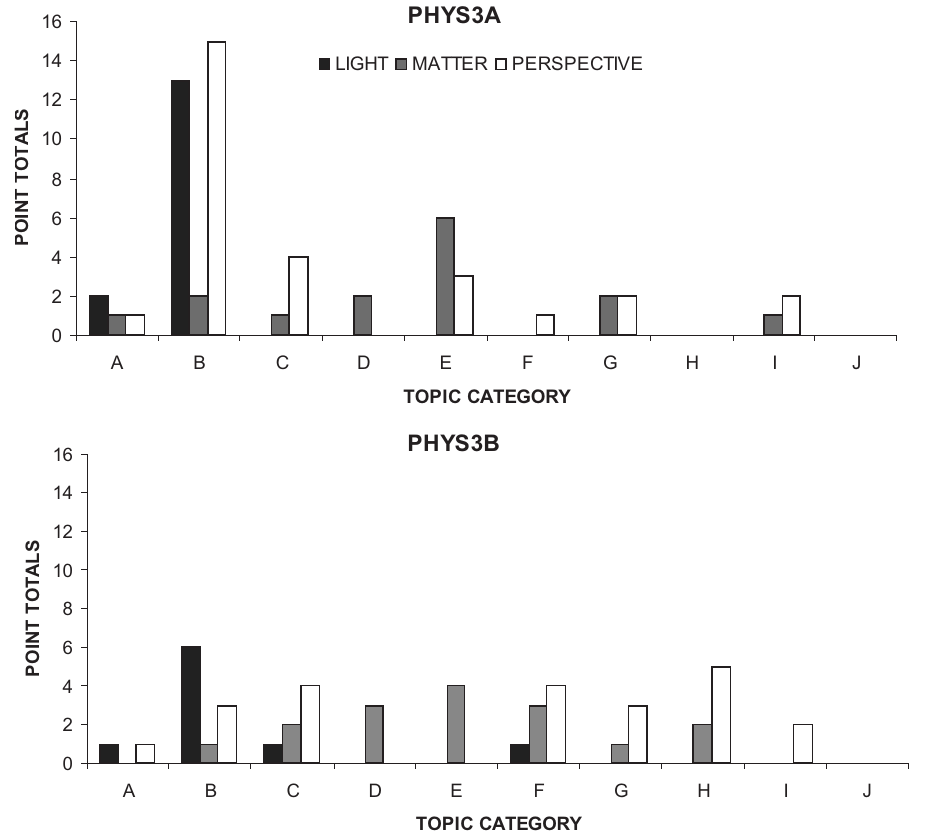
FIG. 1. The occurrence of lec- ture slides for both PHYS3 courses by topic (cid:1) as listed in Table I (cid:2) for each of the themes described in Table II.